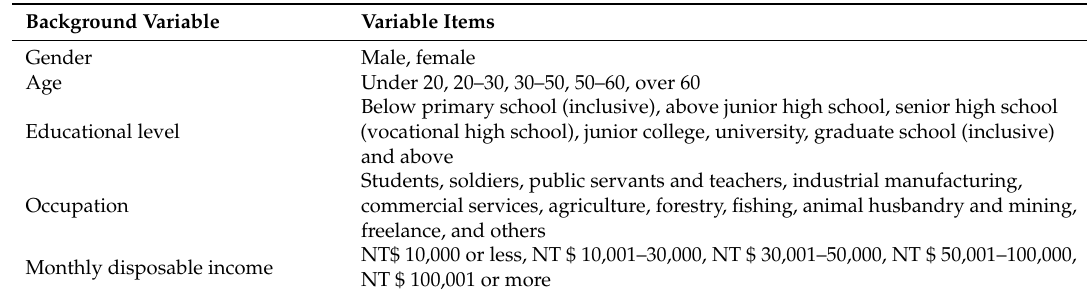
Table 1. Demographic variables.